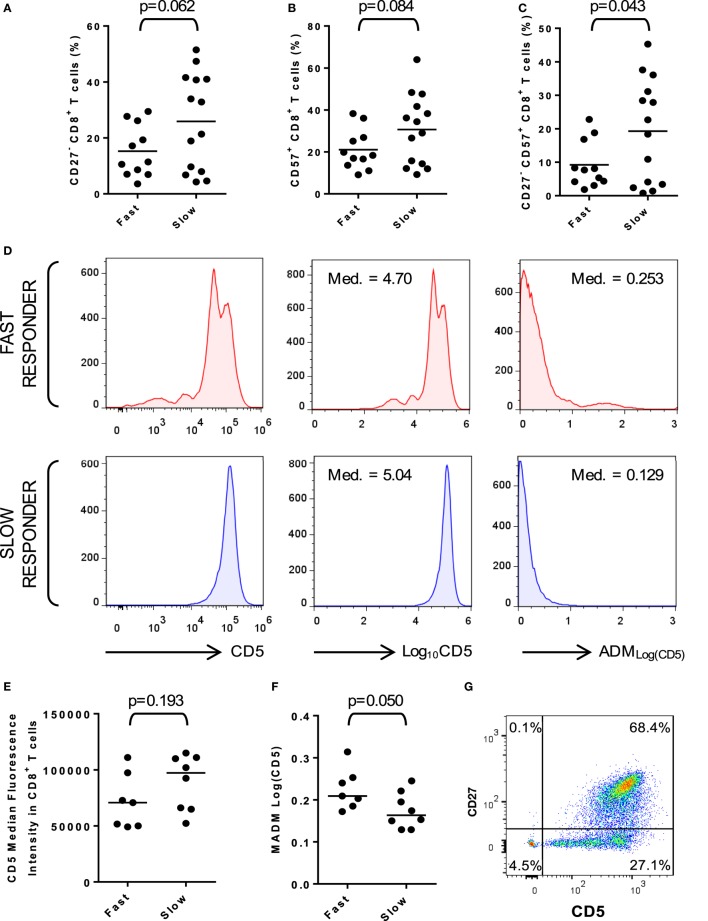
Generalized activation of peripheral blood CD8+ T cells in slow responders. (A) Frequencies of CD27− CD8+ T cells in fast and slow responders. (B) Frequencies of CD57+ CD8+ T cells in fast and slow responders. (C) Frequencies of chronically activated CD27− CD57+ CD8+ T cells in fast and slow responders. (D) Visual representation of the method used to estimate the dispersion of CD5 expression in CD8+ T cells. The examples represent one fast and one slow responder from samples of n = 7 and n = 8, respectively. The first pair of histograms show CD5 fluorescence intensities of >1 plotted on a log-axis. The second pair of histograms show log10-transformed values plotted on a linear-axis and their respective medians (Med.). The third pair of histograms show absolute deviation of log10-transformed values from median (ADM) and the respective medians (MADM). (E) CD5 expression by CD8+ T cells from fast and slow responders estimated by median fluorescence intensity. (F) MADMLog(CD5) in CD8+ T cells from fast and slow responders. Assessing the spread of CD5 expression in CD8+ T cells discriminates better between fast and slow responders. (G) Downregulation of CD5 expression appears to be confined to CD27− CD8+ T cells.